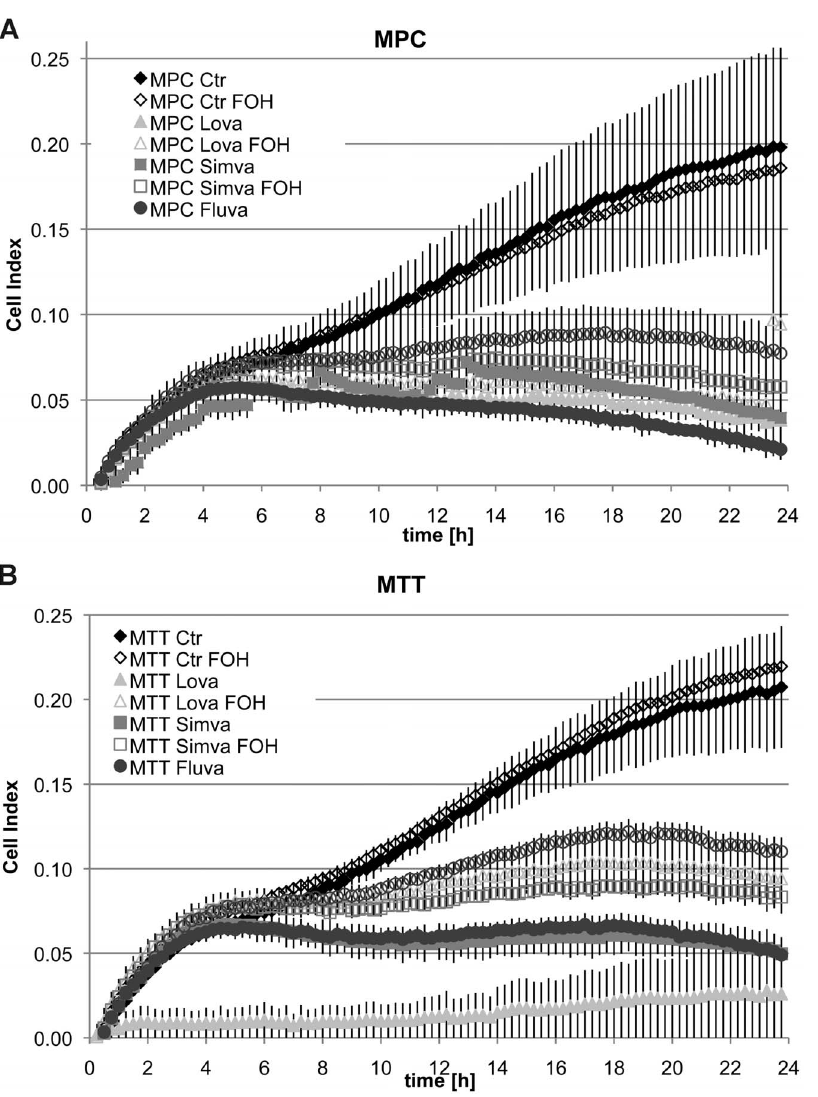
Figure 6. Influence of statin treatment on spontaneous cell migration. MPC (A) and MTT (B) were plated in vehicle (Ctr), 5 m M fluvastatin (Fluva), 5 m M simvastatin (Simva), 5 m M lovastatin (Lova) with or without 100 m M trans, trans farnesol (FOH) and spontaneous migration was recorded for 24.